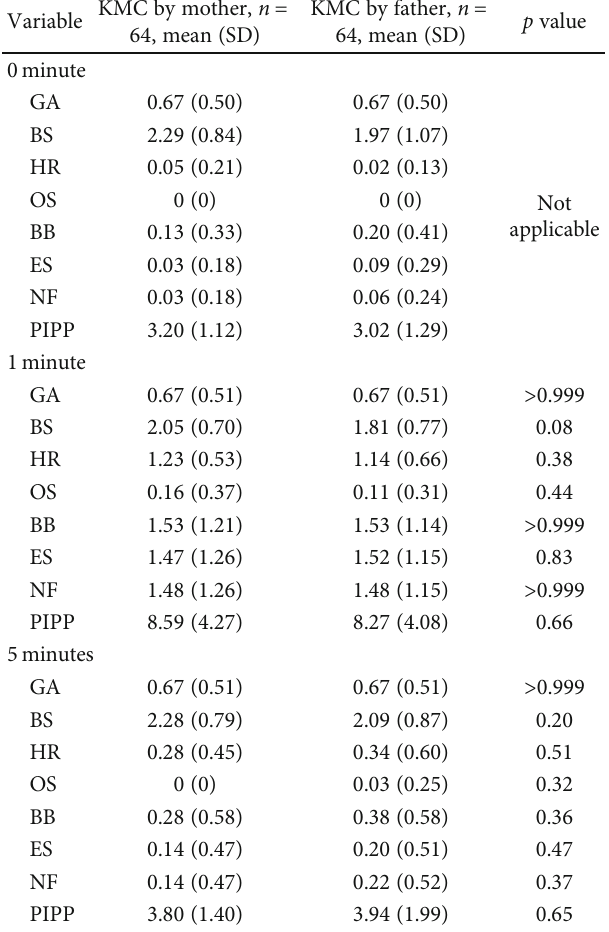
Table 1: Comparison of PIPP scores by groups at various time points. KMC by mother, n = Variable 64 , mean (SD)